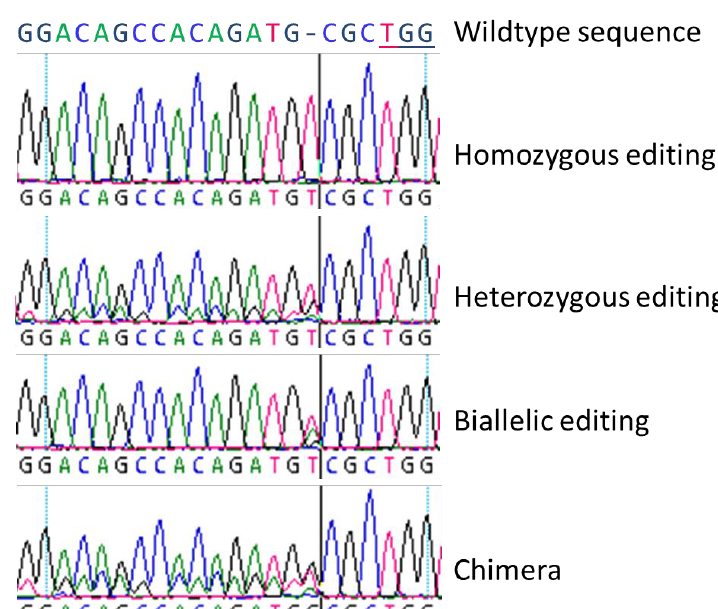
Figure 1. Electropherograms of four basic types of genome editing as found in poplar plants (according to Fan et al. [22]). Four basic types were obtained by Sanger-sequencing for both insertions and deletions, here as example, a single nucleotide insertion at the Cas9 cutting site: ( a ) Homozygous editing with clearly determinable curves, ( b ) heterozygous editing with overlaying wildtype sequence curves behind the cutting site of the Cas9, ( c ) biallelic editing with one overlaying peak at the edited site, and ( d ) a chimeric line with three peaks at the cutting site of Cas9 which contained two different inserted nucleotides and the wildtype and following overlaying curves. The PAM (protospacer adjacent motif) sequence TGG is underlined in the wildtype sequence.